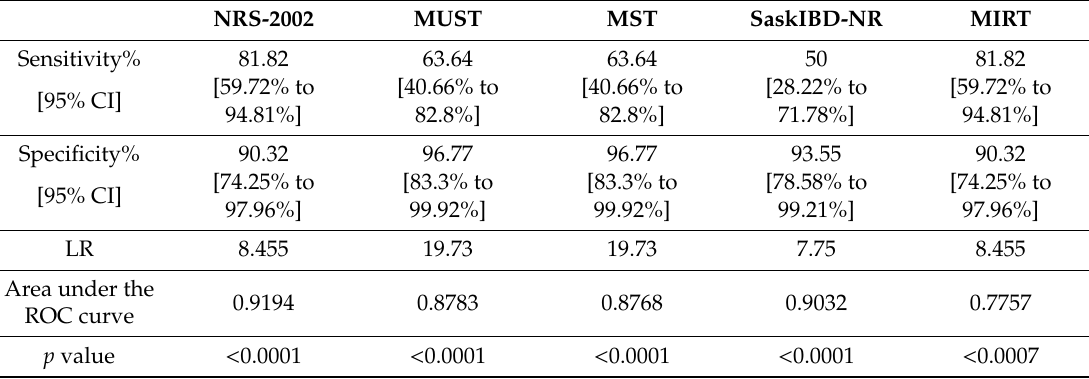
Table 7. Concordance of GLIM diagnosis of malnutrition with the prevalence of high nutritional risk according the screening tools